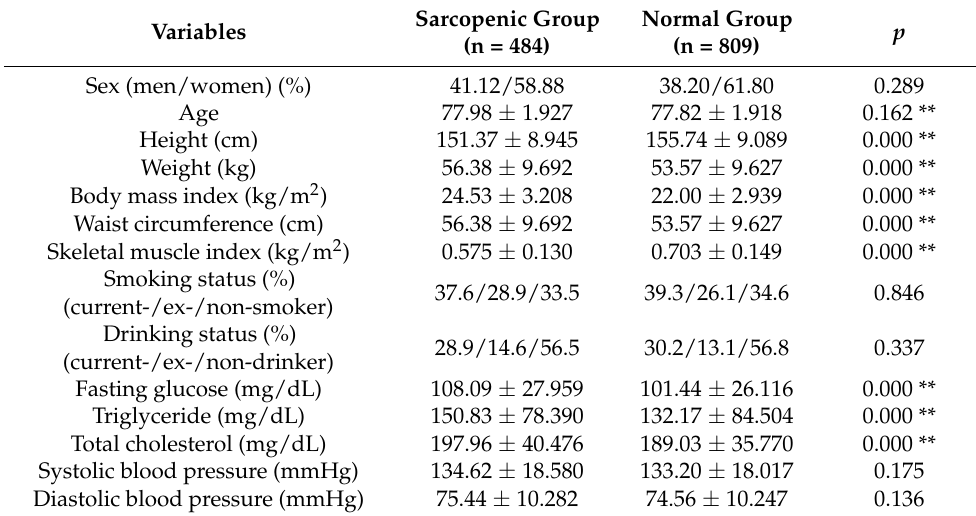
Table 1. General characteristics of the participants (n =